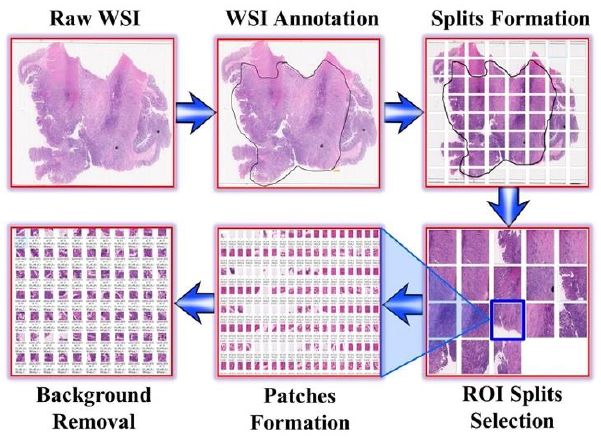
Figure 2. Overall data collection, annotation, and preprocessing method for CRC WSI.